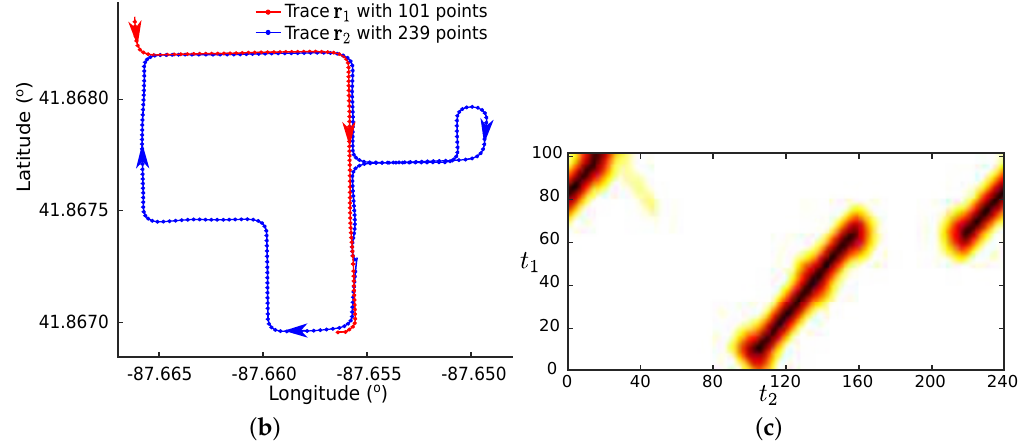
Figure 2. Examples of GNSS traces fail to find common sub-tracks using the LCSS method. ( a ) example 2 of two GNSS traces moving in opposite directions on the same road; ( b ) the local distance matrix for Example 2; ( c ) example 3 of two GNSS traces sharing multiple common sub-tracks; ( d ) the local distance matrix for Example